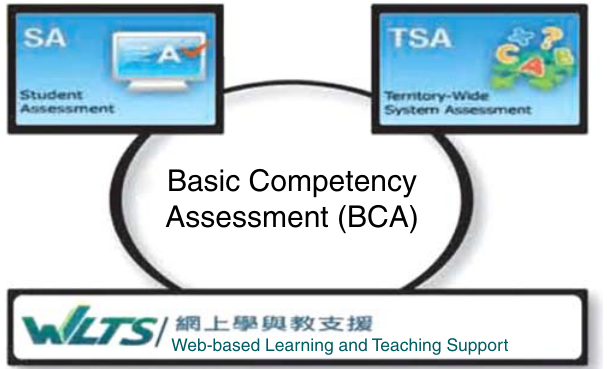
Figure 3. Components of